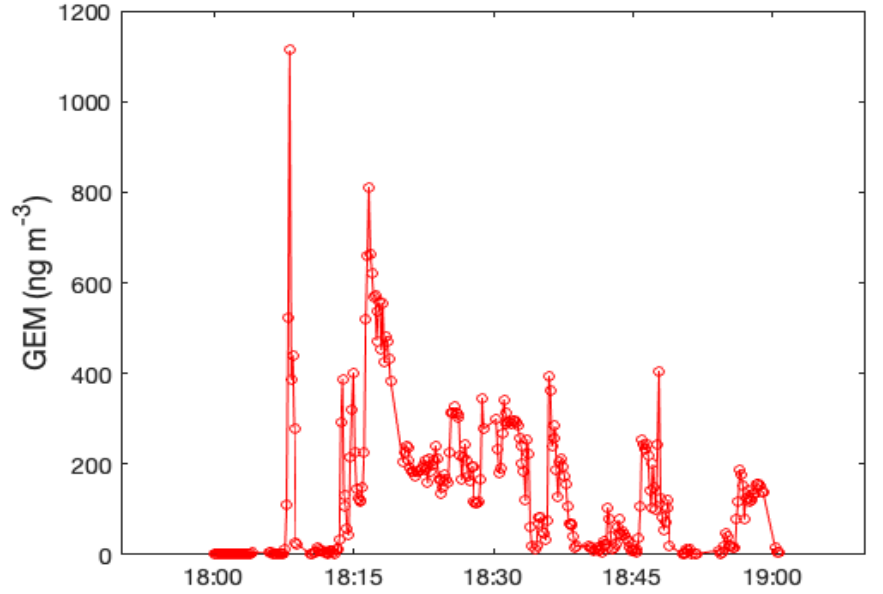
Figure 5. Temporal variation of GEM in a time span of 1 h measured on the 28th of June 2020 in proximity of the chlor-alkali plant of Pieve Vergonte.